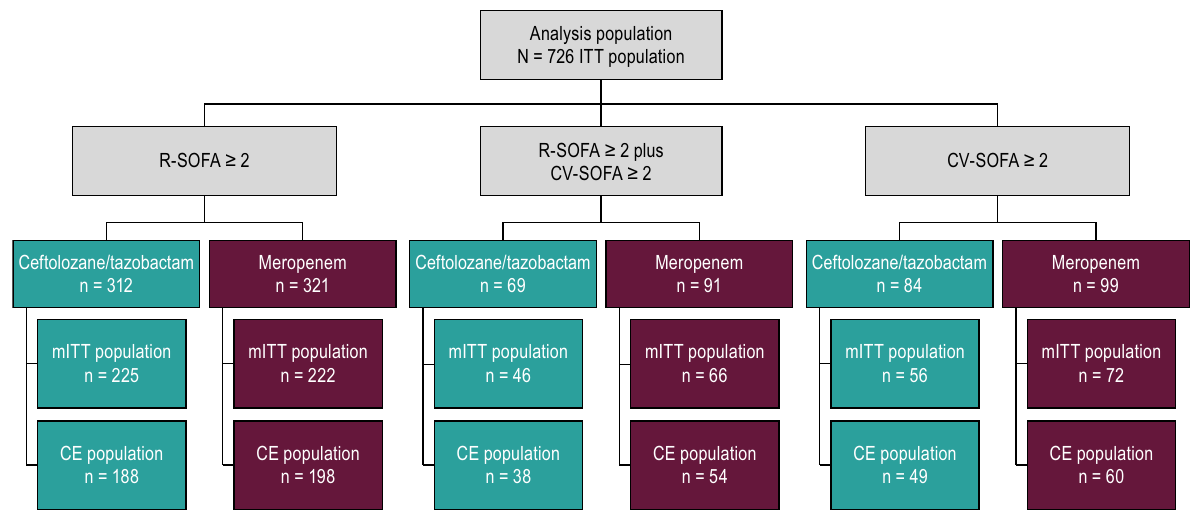
Fig. 2 Participant and analysis population flow chart. CE clinically evaluable, CV-SOFA cardiovascular SOFA component score, ITT intention‑to‑treat, LRT lower respiratory tract, mITT microbiologic intention‑to‑treat, R-SOFA respiratory SOFA component score, SOFA Sequential Organ